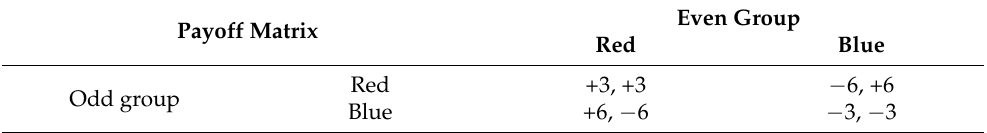
Table 1. Game matrix of the “red-blue” experiment. Payoff